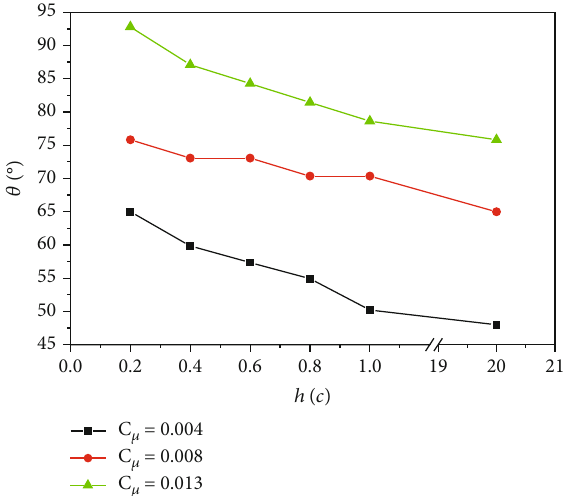
Figure 34: Curves of separation angle versus ride height for the airfoil with upper slot blowing and C μ = 0 : 004 ~ 0 : 013 at α = 8 ° :.